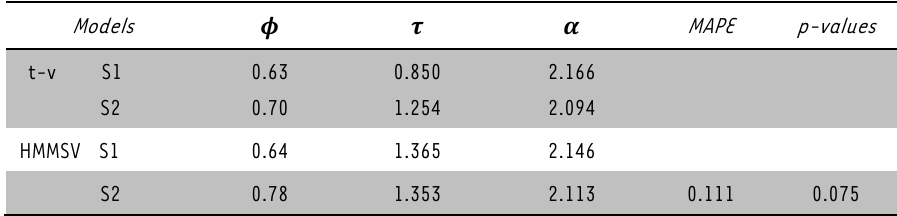
TABLE 4: Statistical performance results for the simulated data set and the true parameter sets compared with those obtained from HMM-SV